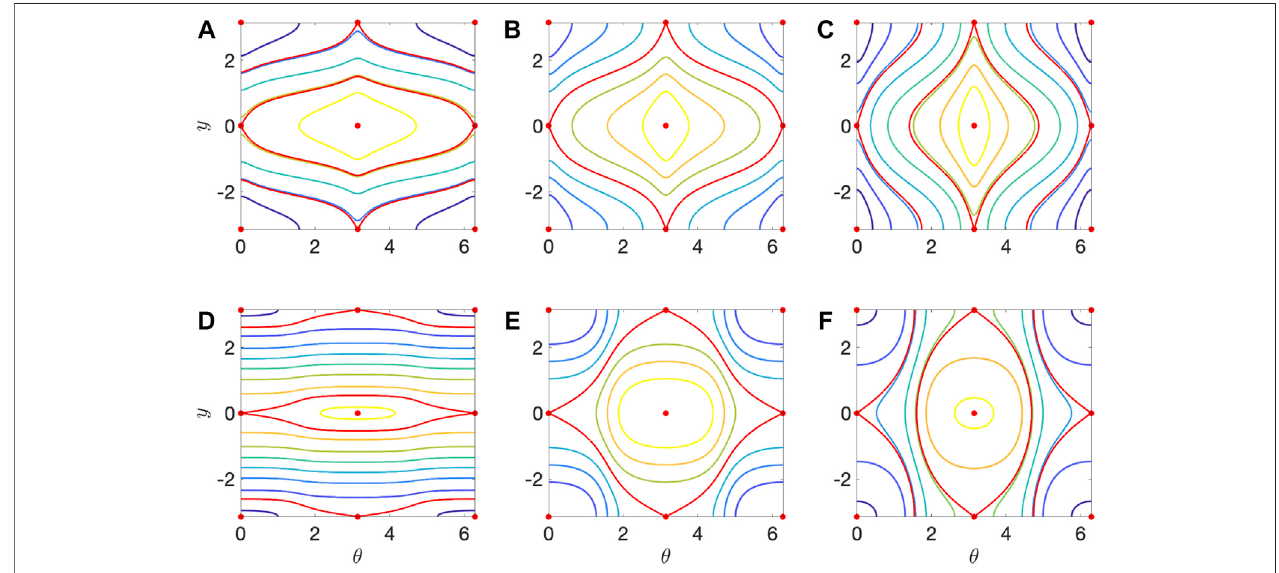
FIGURE2| Phaseportraitsof Eq.3 for (A – C) α (cid:1) 0.9and (D – F) α (cid:1) − 0.7. (A) v 0 (cid:1) 0.2. (B) v 0 (cid:1) v *( α ) (cid:1) 0.430. (C) v 0 (cid:1) 0.8. (D) v 0 (cid:1) 0.02. (E) v 0 (cid:1) v *( α ) (cid:1) 0.285. (F) v 0 (cid:1) 0.6. Red dots are the fi xed points of Eq. 3 . Red curves are the separatrices emanating out of the saddle fi xed points at ( y , θ ) (cid:1) (0, 0) and ( y , θ ) (cid:1) ( ± π , π ). The color of each remaining curve corresponds to a distinct value of Ψ .